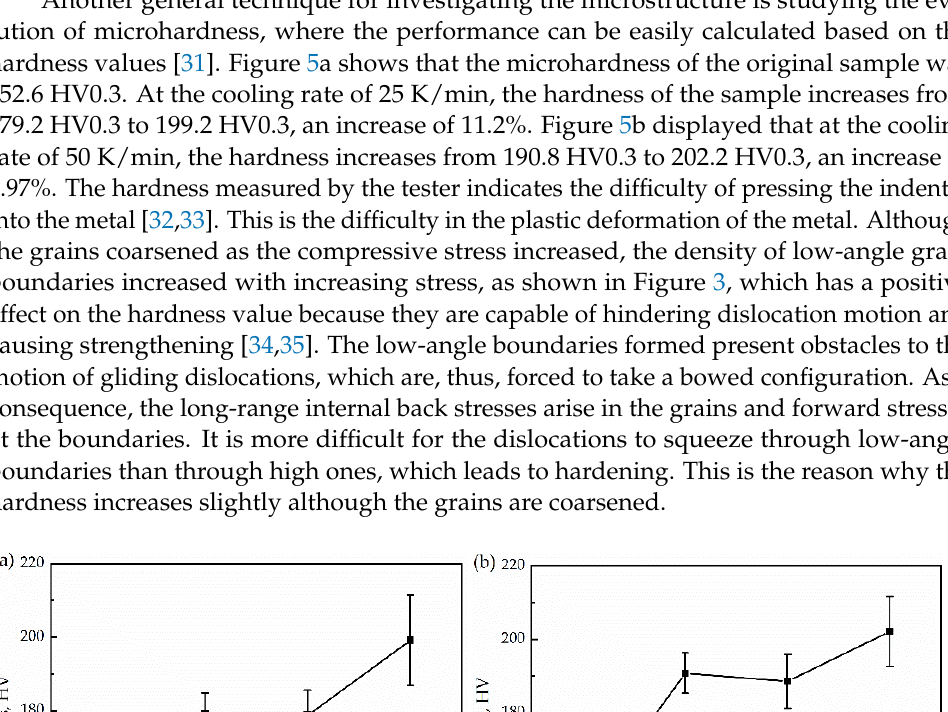
Figure 4. The average grain radius is determined by the line-intercept method. ( a ) 25 K/min; ( b ) 50 K/min.